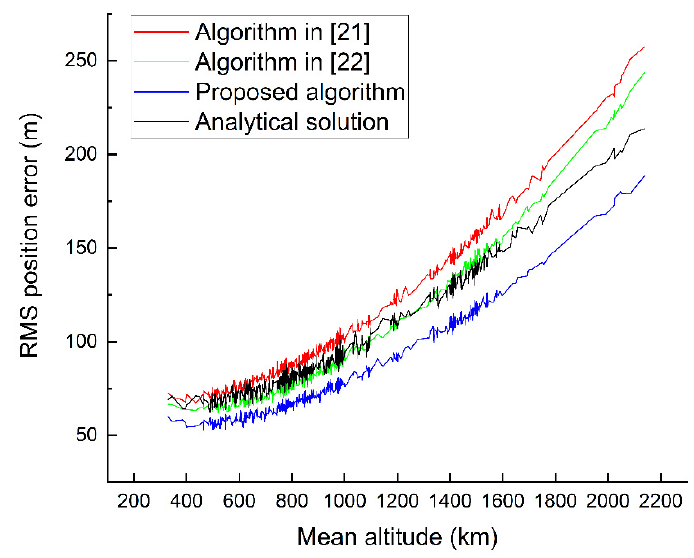
Figure 5. The RMS position errors for LEO space debris.